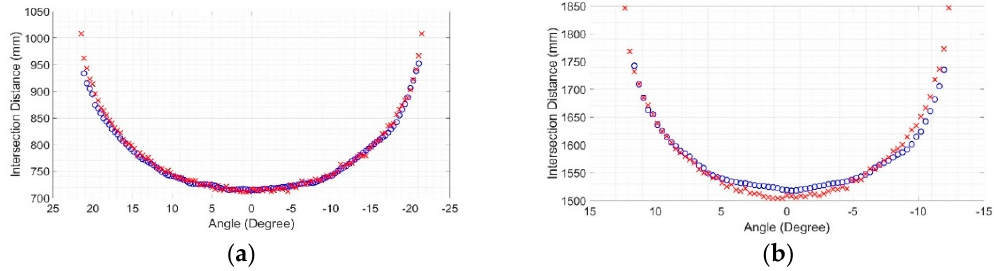
Figure 10. Intersection maps: ( a ) At 700 mm of the sensor’s central ray; ( b ) At 1500 mm of the sensor’s